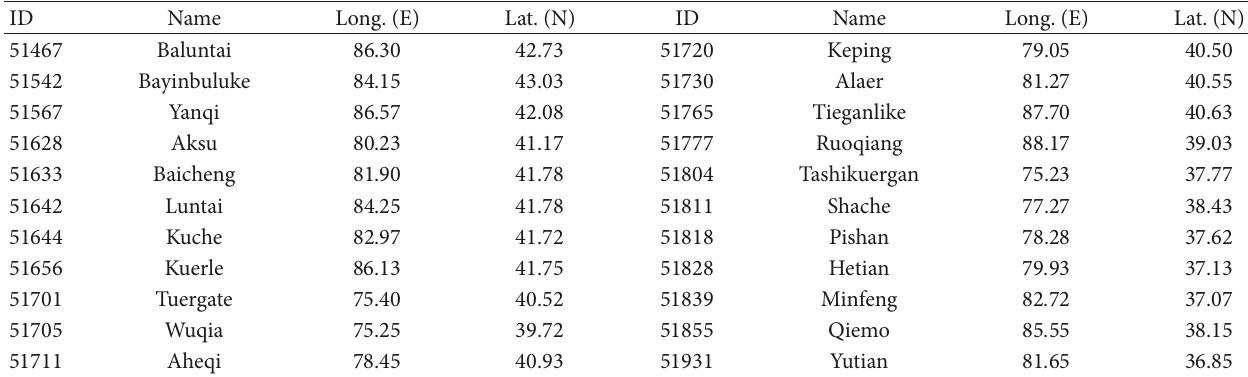
Table 1: The summaries of weather stations in the TRB in this study.